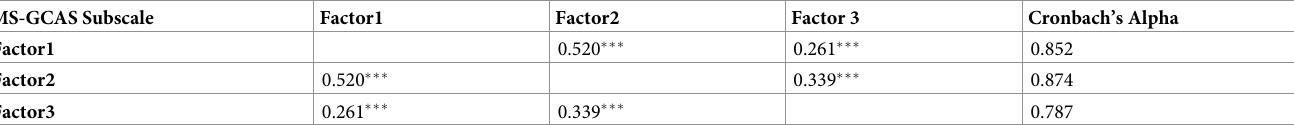
Table 3. Internal consistency reliability and correlation between the three factor scores of the MS-GCAS.